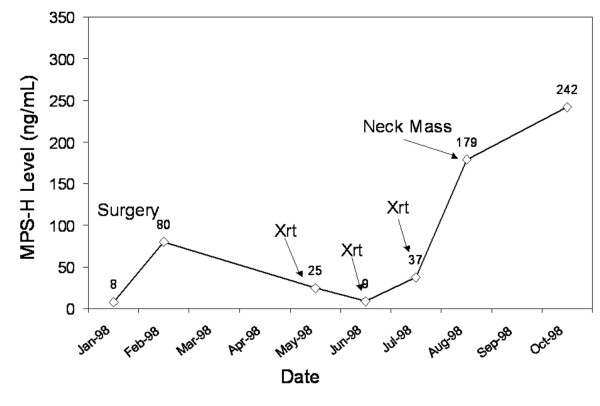
Patient without evidence of disease from surgery through radiation therapy (draws 1–5). The patient suffered a recurrence of clinical disease following radiation therapy (draws 6–8), which progressed until death.